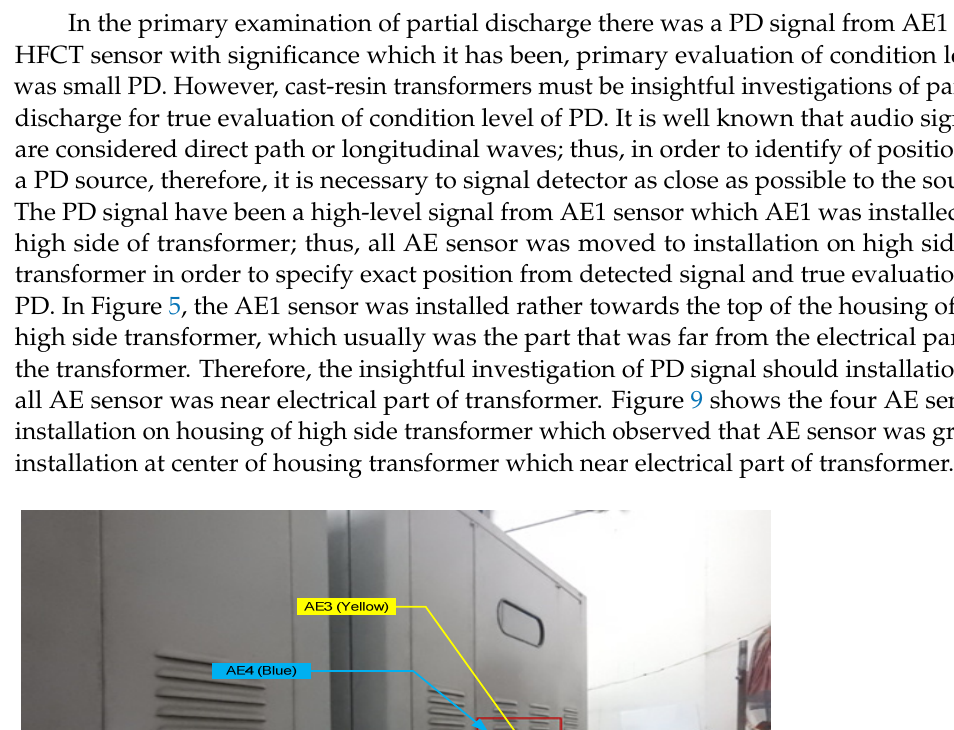
Figure 8. the PD signal waveform from HFCT sensor.